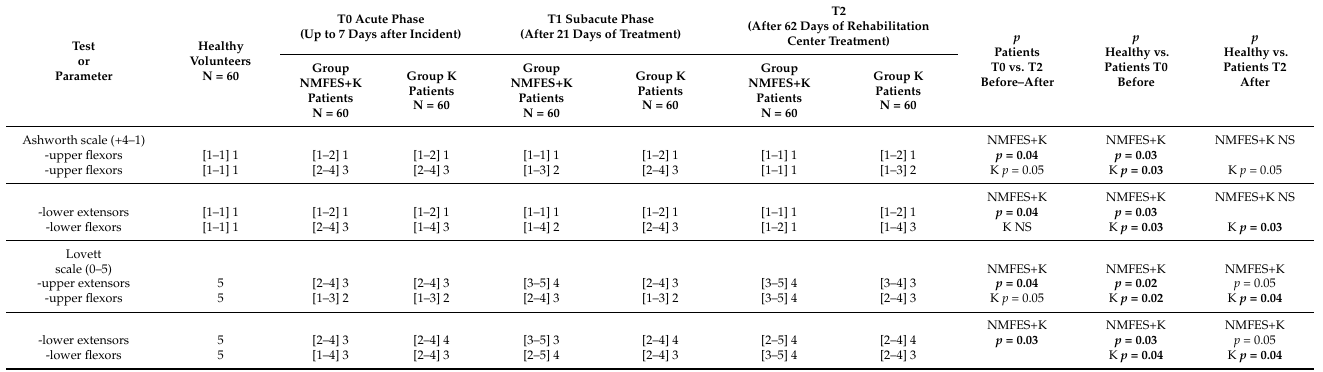
Table 2. Comparison of results from clinical studies recorded in two groups of patients and healthy subjects. Results refer to recordings performed in patients on a paretic side identified in the prelimi- nary clinical examinations. When comparing the results of the Ashworth and Lovett scale tests, they were cumulatively averaged for the examination of the extensor and flexor muscles of the upper and lower extremities. Ranges and median values are